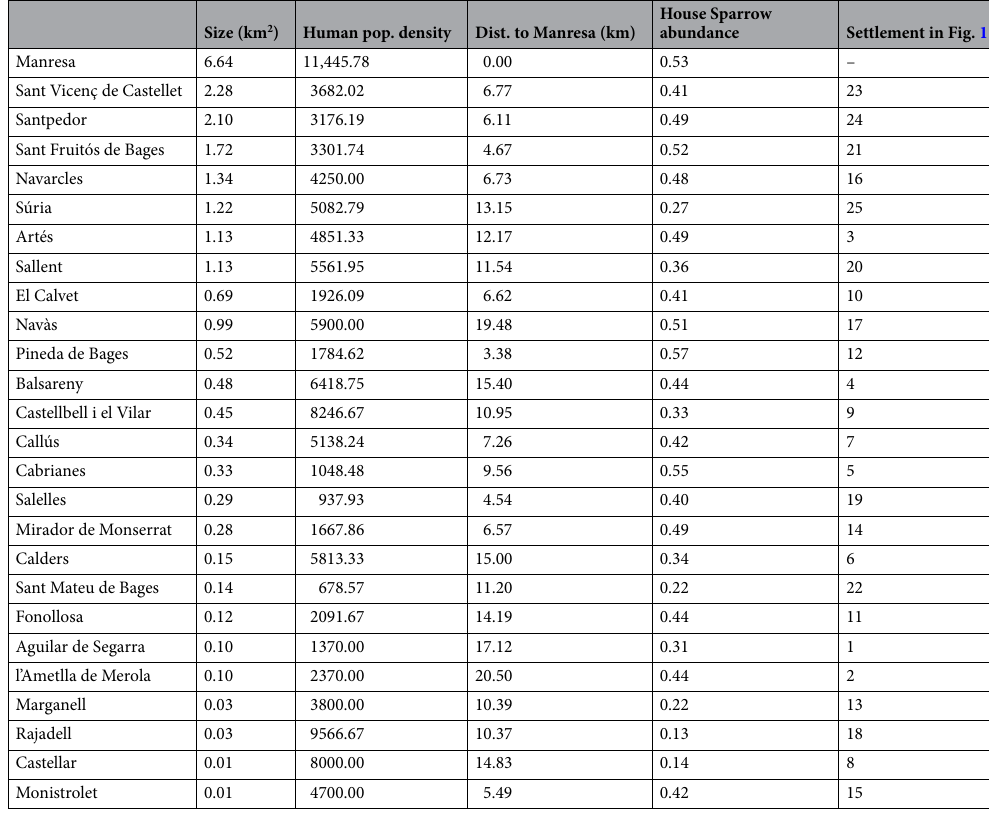
Table 1. Size, total human population density, distance to Manresa, and House Sparrow abundance of the studied human settlements. Population data was obtained from the Statistical Institute of Catalonia 41 .